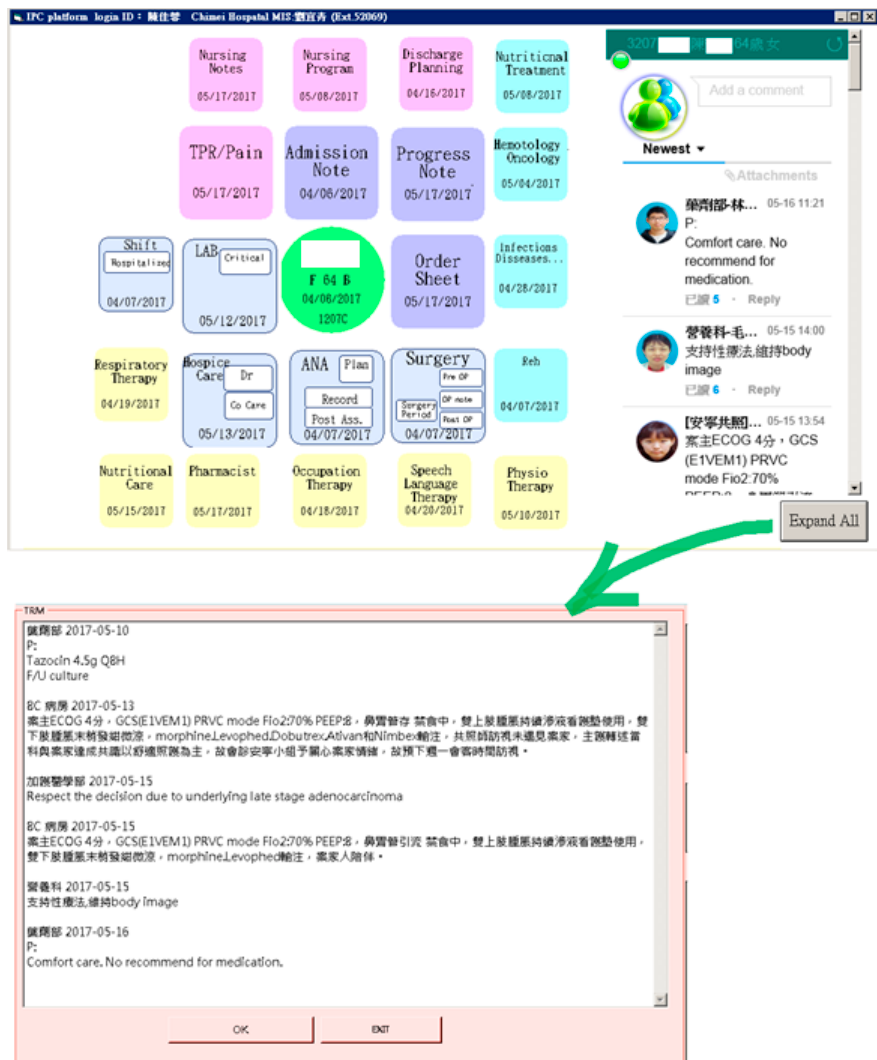
Figure 4. Master page with two functional areas, and the expanded page displaying the message history.